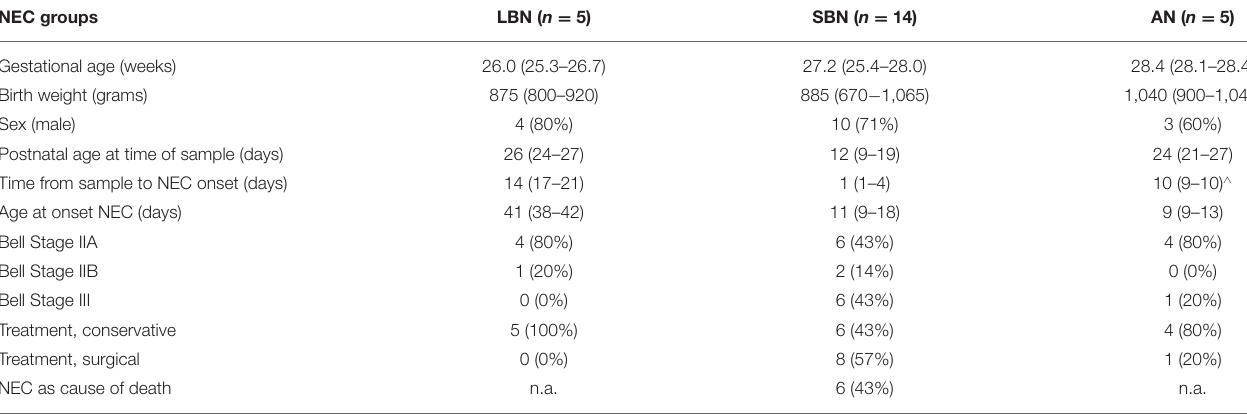
TABLE 4 | Characteristics of the NEC infants at three separate time frames.